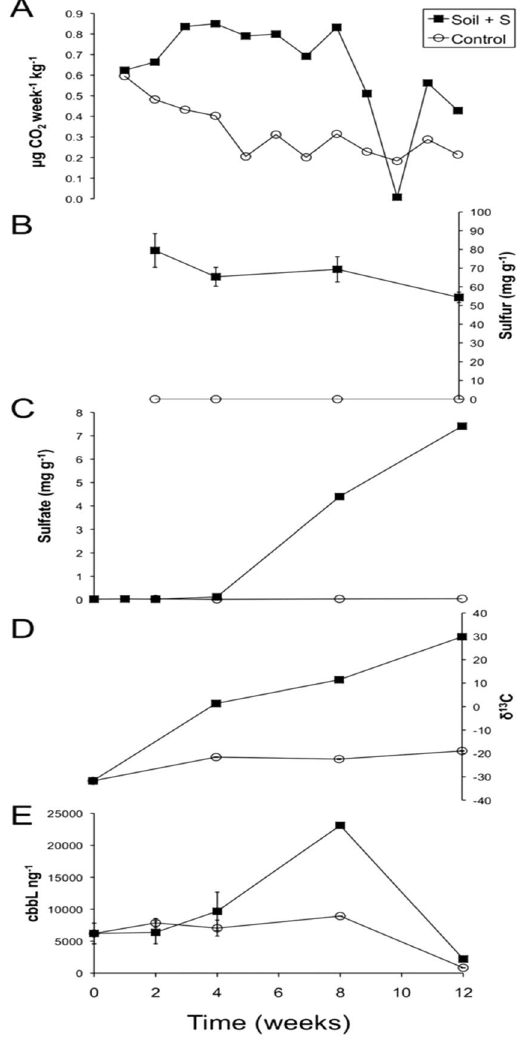
weeks. ( A ) Average efflux rates of CO 2 from both soils over time (Methods, Supplementary Tables 1 and 2 and Supplementary Information section 1). Positive values indicate CO 2 efflux from the soil surface into the chamber atmosphere. ( B ) Sulfur concentration in both soils, ( C ) sulfate concentration in both soils, ( D ) average δ 13 C values (‰) of microbial PLFAs (average StDev ≤ 1.00‰) in both soils (Supplementary Information Table 3) and ( E ) RubisCO gene copy ( cbbL ) concentrations for both